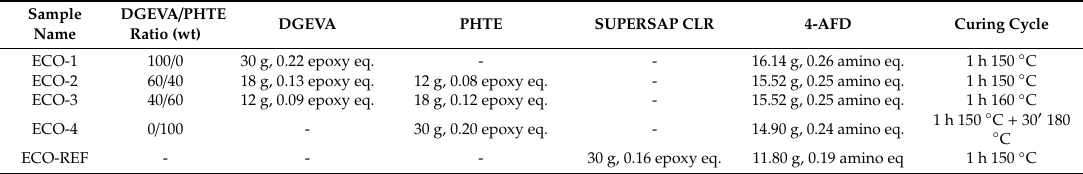
Table 1. Formulations and curing cycle of the prepared epoxy